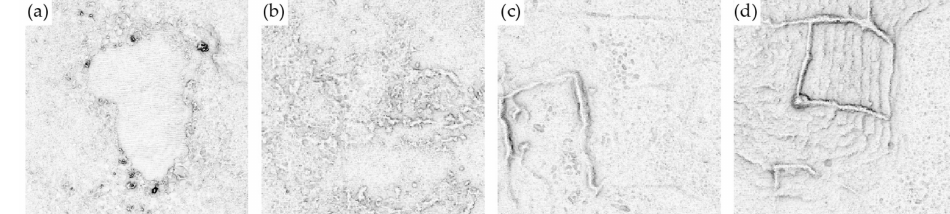
Figure 14. Examples of misclassifications between terrain and aguadas; an aguada misclassified as terrain ( a ), and terrain misclassified as an aguada ( b ). Unannotated anthropogenic features among the terrain samples result in terrain misclassified as an aguada ( c ) and terrain misclassified as a platform ( d ). The scale